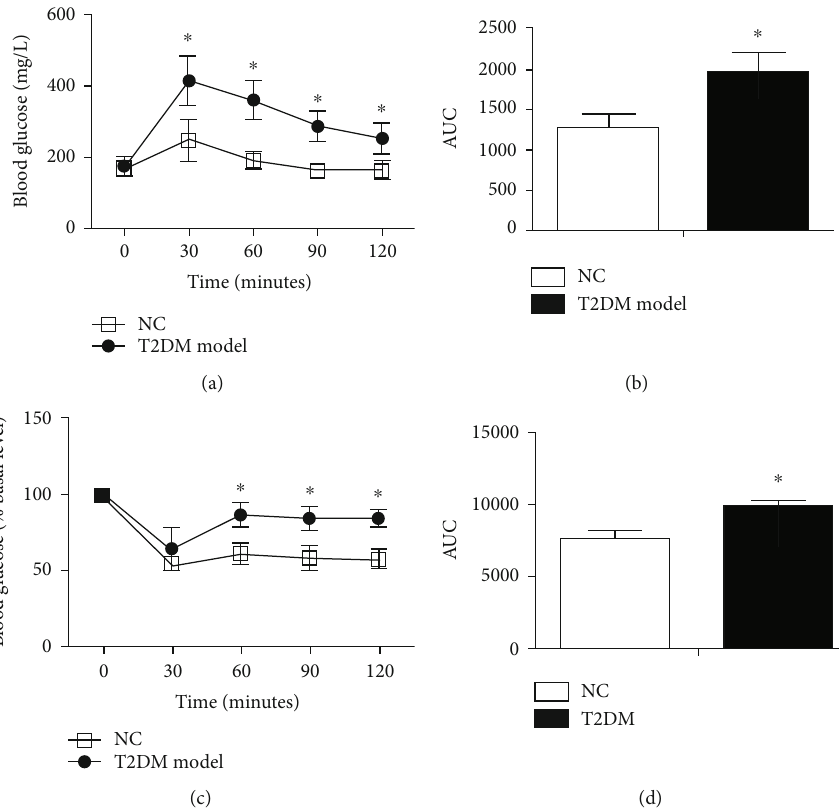
Figure 3: Blood glucose levels and AUCs of blood glucose in NC and T2DM group after IPGTT (a, b) and IPITT (c, d) (data presented as mean ± SEM . ∗ P < 0 : 05 vs. NC mice, n = 5 ).